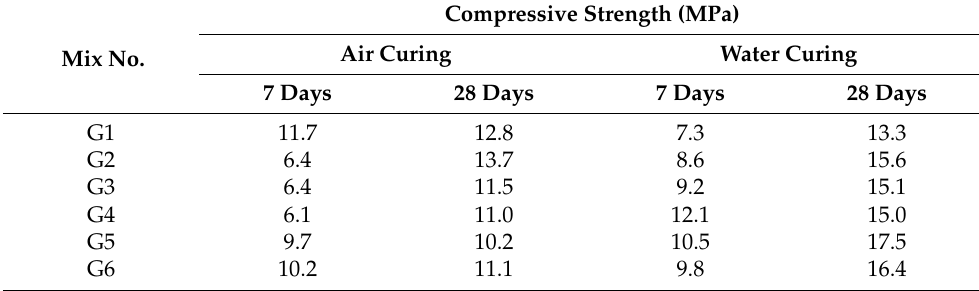
Table 4. Results of compressive